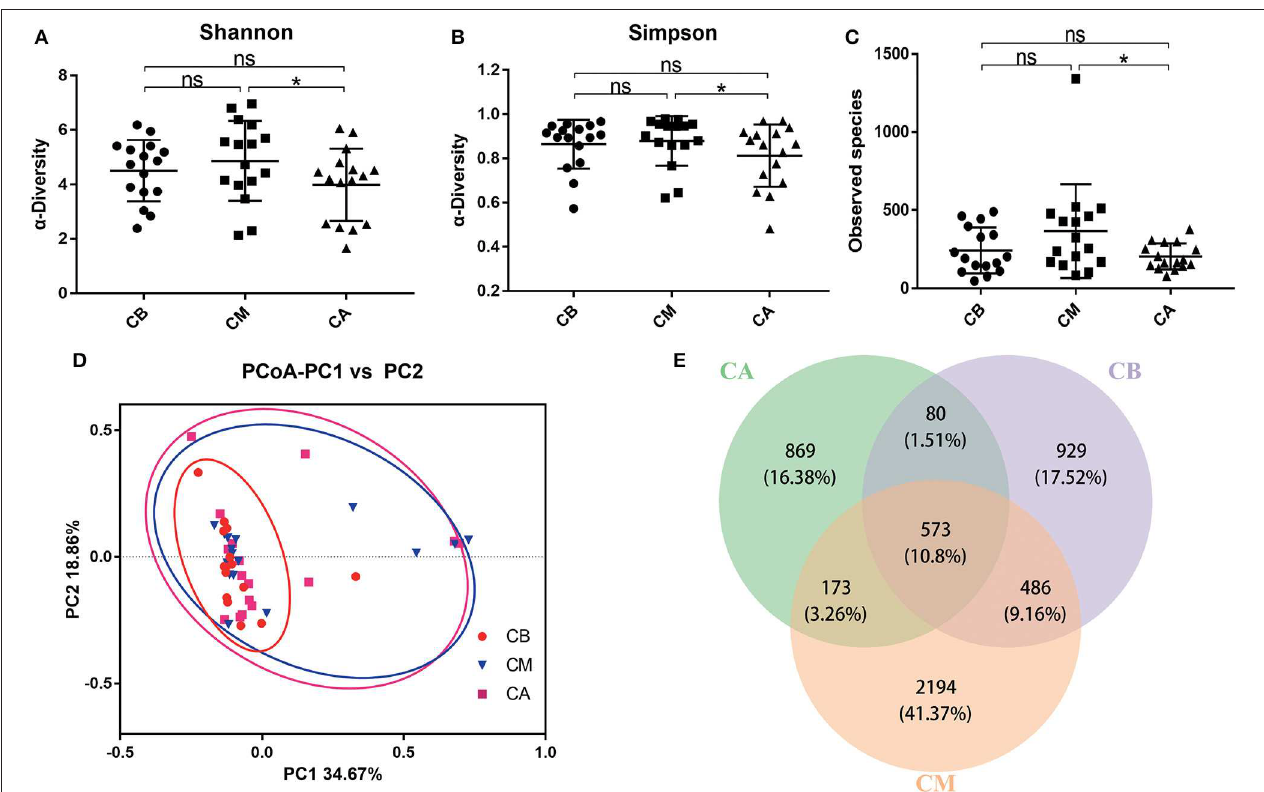
FIGURE 1 | Effect of bowel preparation on intestinal microbiota. (A) , Shannon index; (B) , Simpson index; (C) , Observed species; (D) , PCoA of β diversity index; (E) , scalar-Venn representation. CB, control group 3 days before bowel preparation ( n = 16); CM, control group during bowel preparation ( n = 16); CA, control group 5–7 days after bowel preparation ( n = 16). Data are presented as means ± SD. ns, P > 0.05; * P < 0.05.